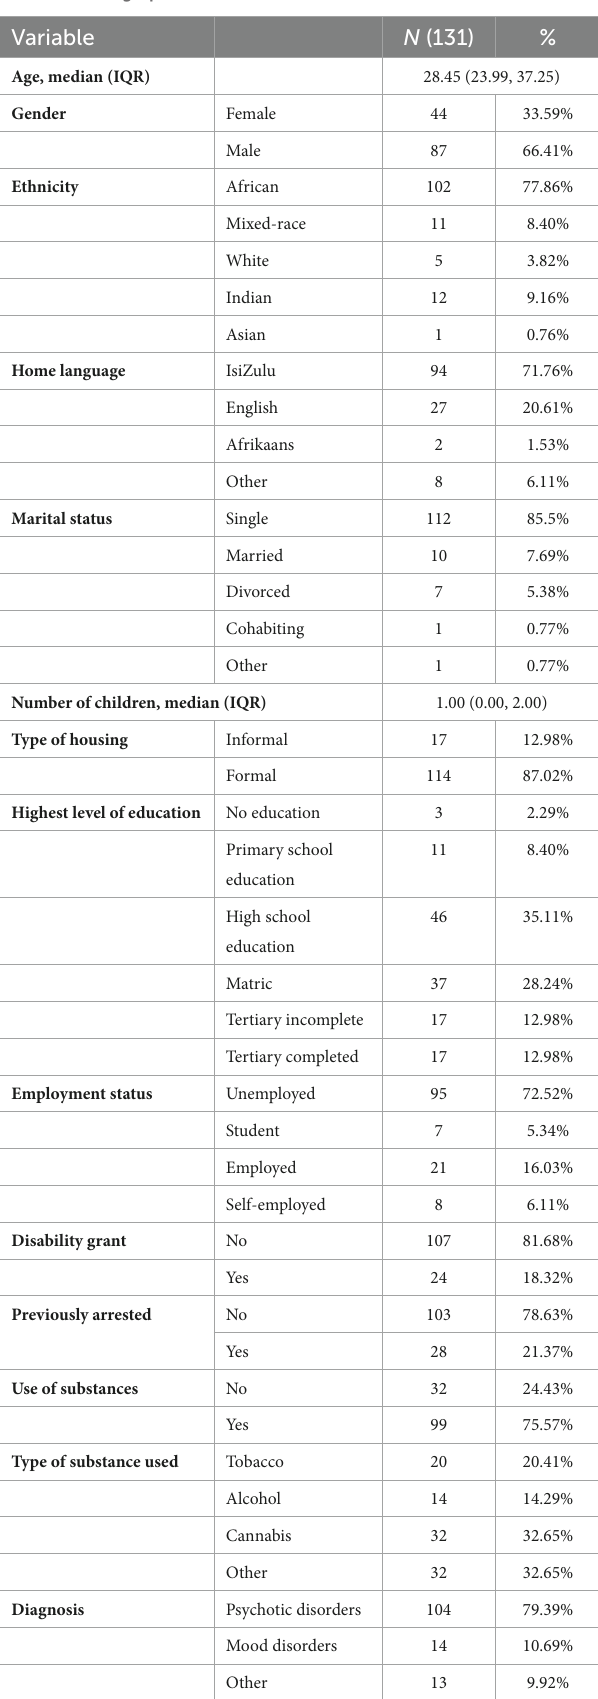
TABLE 1 Demographic information. TABLE 2 Experience of the current admission using the